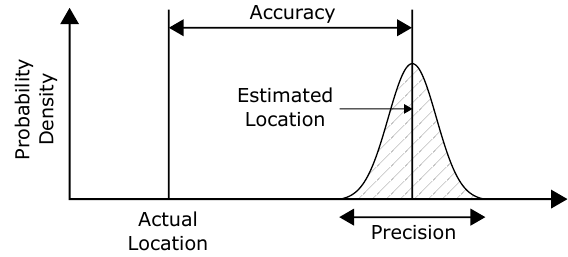
Figure 1. Auditory localization accuracy and precision. Adapted from